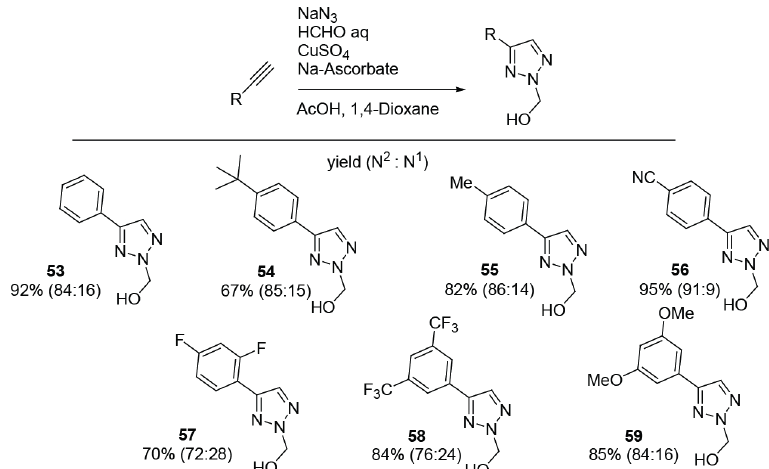
Figure 11 - Synthesis of